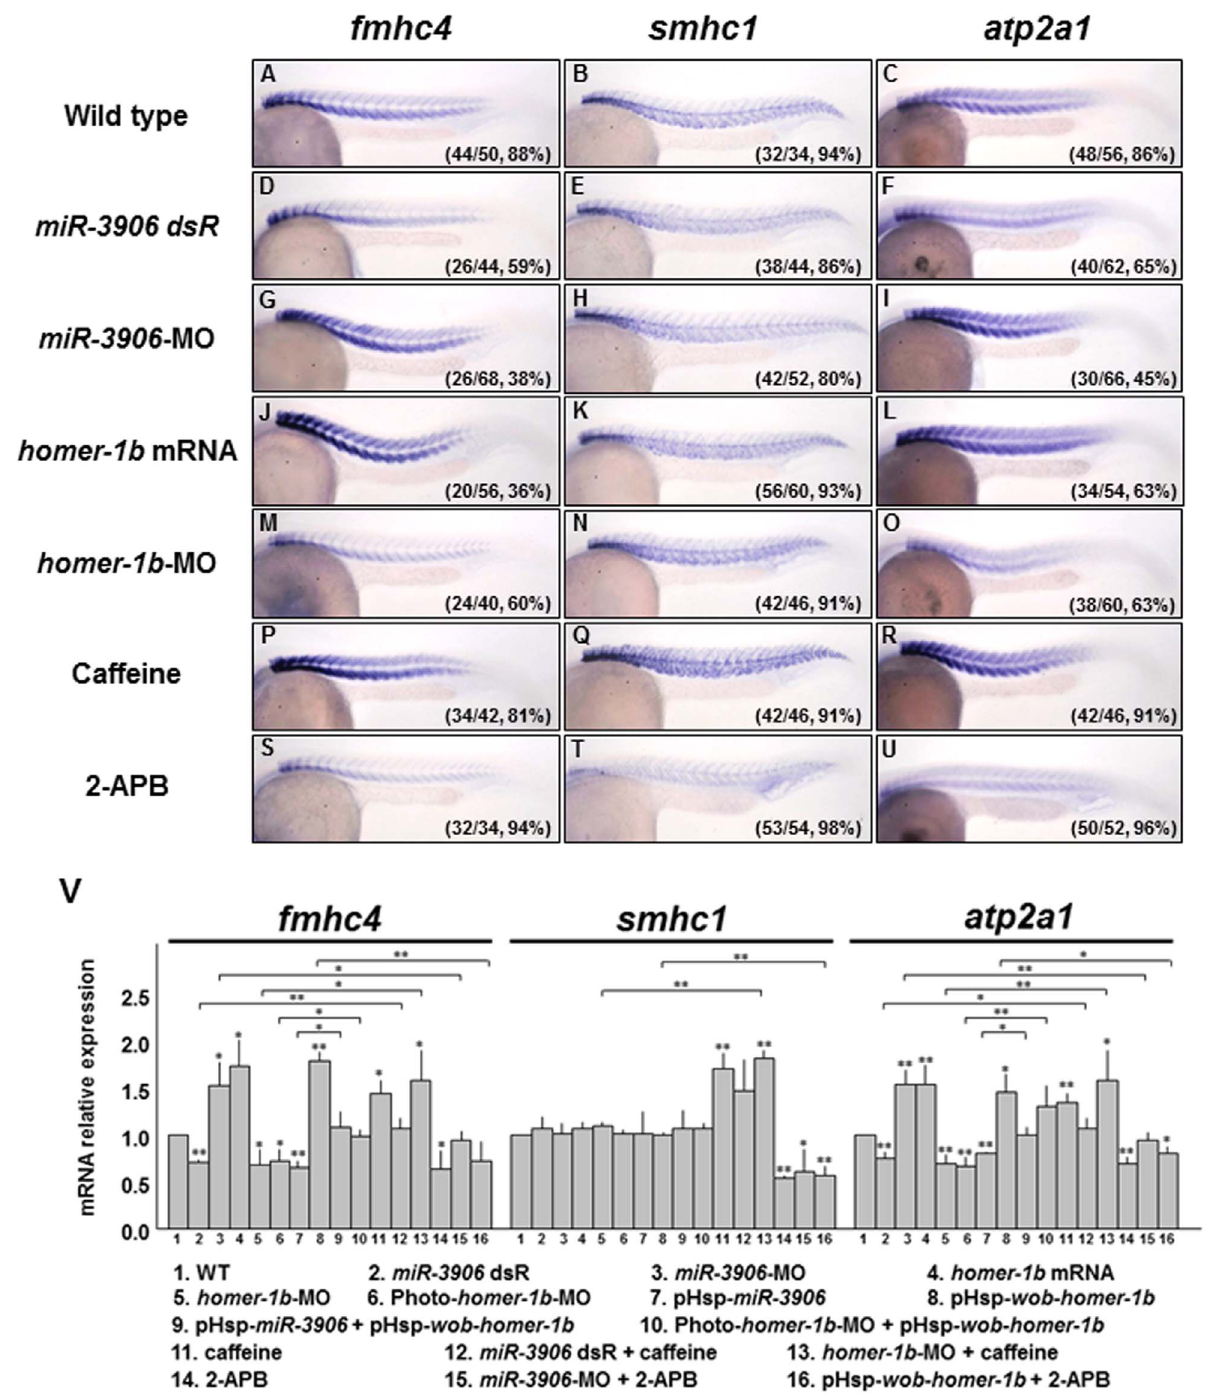
Figure 6. Injection of either miR-3906- MO or homer-1b mRNA affects fast muscle differentiation by regulating the calcium concentration in muscle cells. ( A–C ) Wild-type (WT) zebrafish embryos at 24 hpf and embryos injected with ( D–F ) miR-3906 dsR (1.5 ng), ( G–I ) miR-3906 -MO (8 ng), ( J–L ) homer-1b mRNA (400 pg), and ( M–O ) homer-1b -MO (3 ng) were collected, and the expressions of fast muscle type fmhc4 , slow muscle type smhc1 , and calcium-sensitive gene atp2a1 were detected by WISH. ( P–R ) Embryos soaked with caffeine served as a positive control, indicating that [Ca 2 + ] i was increased. ( S–U ) Embryos soaked with 2-APB served as a negative control, indicating that [Ca 2 + ] i was reduced. Compared to WT ( A ), the expression of fmhc4 in the embryos injected with miR-3906 -MO ( G ), homer-1b -mRNA ( J ) and soaked in caffeine ( P ) was increased. The expression of fmhc4 in the embryos injected with miR-3906 dsR ( D ), homer-1b -MO ( M ) and soaked in 2-APB ( S ) was decreased. The expressions of smhc1 in the embryos injected with miR-3906 and homer-1b showed no difference ( B, E, H and K ), while smhc1 expression was increased in embryos soaked in caffeine ( Q ) and reduced in embryos soaked in 2-APB ( T ). The expression patterns of atp2a1 ( F, I, L, O, R and U ) in the examined embryos displayed a result similar to that of fmhc4. ( V ) The expression levels of the examined genes were quantified by q-PCR analysis after embryos were treated as indicated. Three rescue experiments were included: co-injection of pHsp- wob-homer-1b (lanes 9 and 10), soaking with caffeine (lanes 12